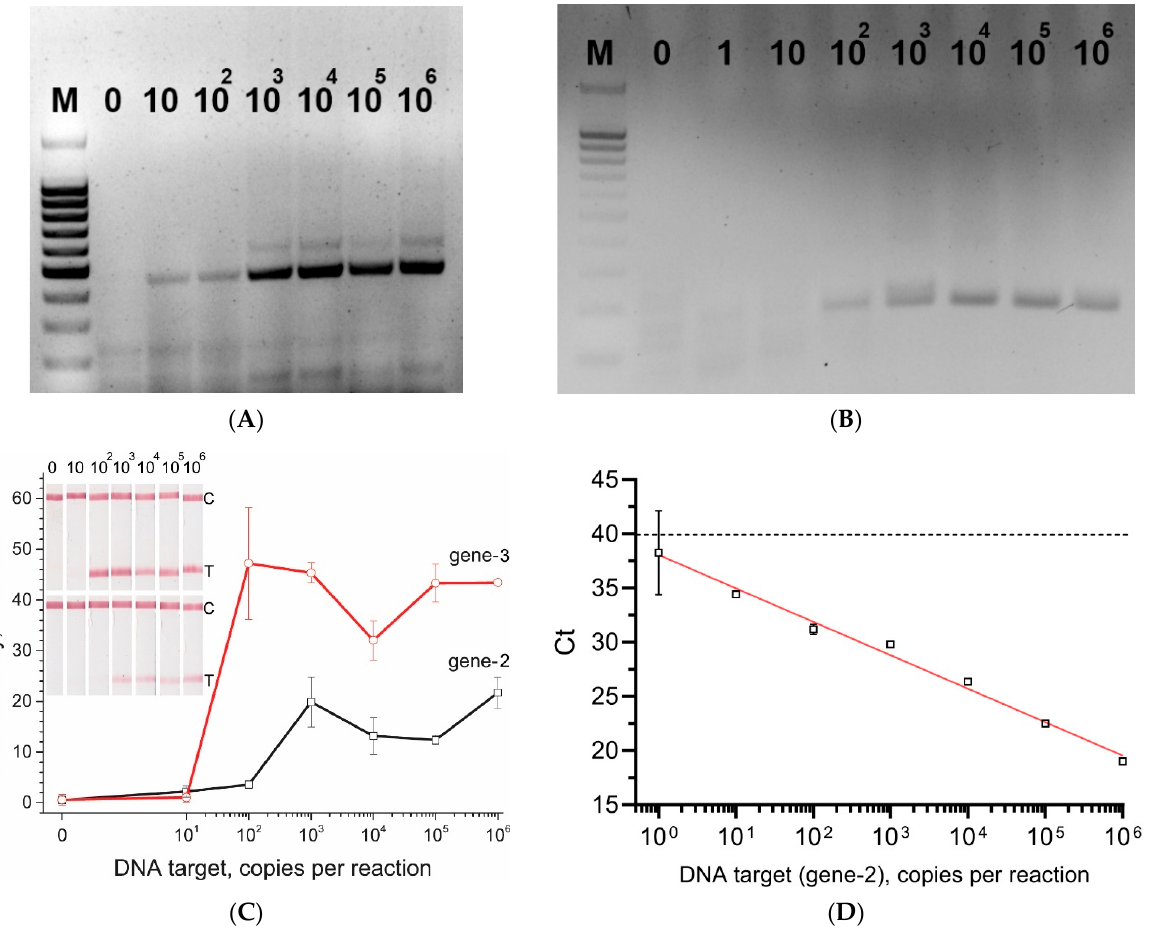
Figure 3. Results of amplification of the DNA fragments of gene-2 and gene-3. ( A ) RPA visualization of gene-2 amplicons on 2% agarose gel after electrophoresis; ( B ) RPA imaging of gene-3 amplicons on 2% agarose gel after electrophoresis; ( C ) test strips after RPA-LFT (the number of DNA copies in the reaction is indicated above the strips; 0 is the negative control, C means control zone, T means test zone) and the corresponding concentration dependences of the intensity of the test zones on a number of DNA copies; ( D ) Calibration plot of qPCR for DNA fragment of gene-3. Dash line indicates the limit cycle for reliable detection of gene-3.